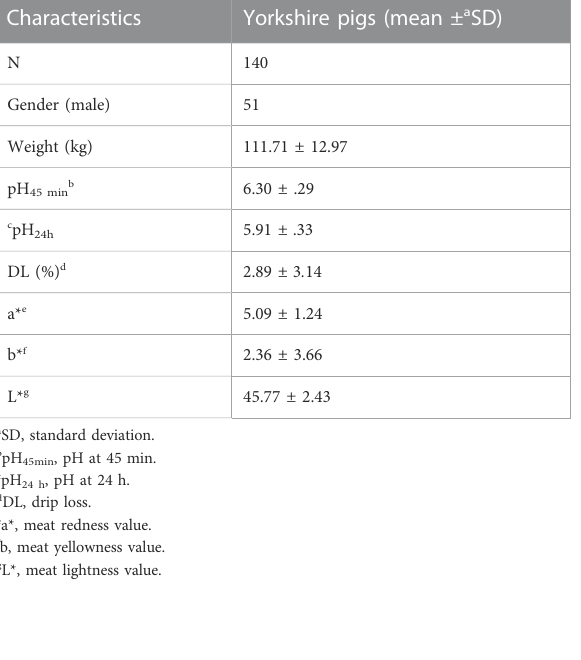
TABLE 1 Descriptive statistics of meat quality characteristics of muscular tissue from Yorkshire pigs.